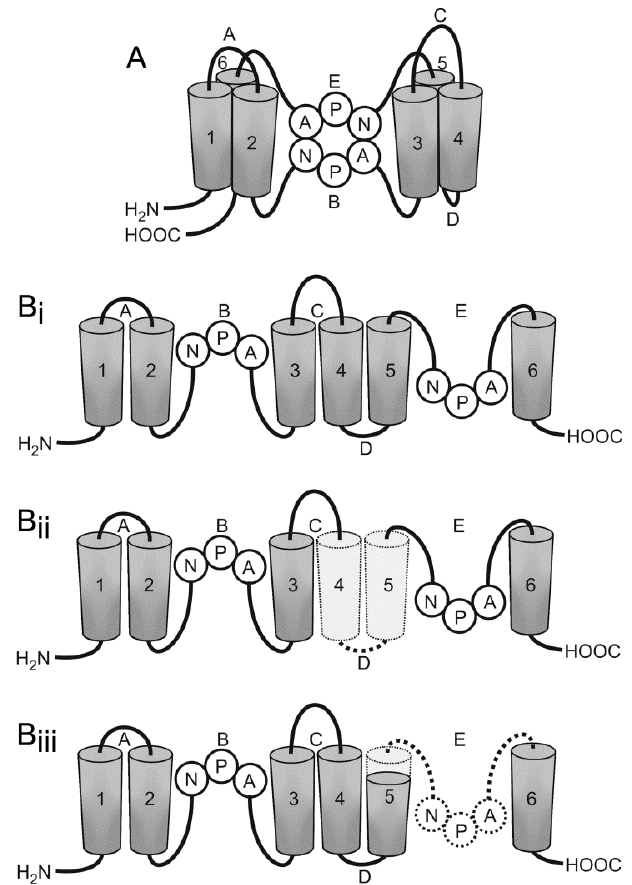
Figure 1. Aquaporin 4 (AQP4) isoforms differ in structure. ( A ) The proposed hourglass model of AQP4. Loops B and E contain NPA motifs (Asn-Pro-Ala), which form an aqueous pore in the membrane bilayer; and ( B ) schematic representations of the AQP4 channel and its isoforms. ( i ) AQP4a, AQP4c, and AQP4e have six bilayer-spanning domains (1–6) and five interconnecting loops (A–E); ( ii ) AQP4b, AQP4d, AQP4f isoforms lack helices 4 and 5 together with their interconnecting loop D; and ( iii ) AQP4- ∆ isoform lacks the final part of helix 5 and loop E. Table 1. Aquaporin (AQP) types in astrocytes.